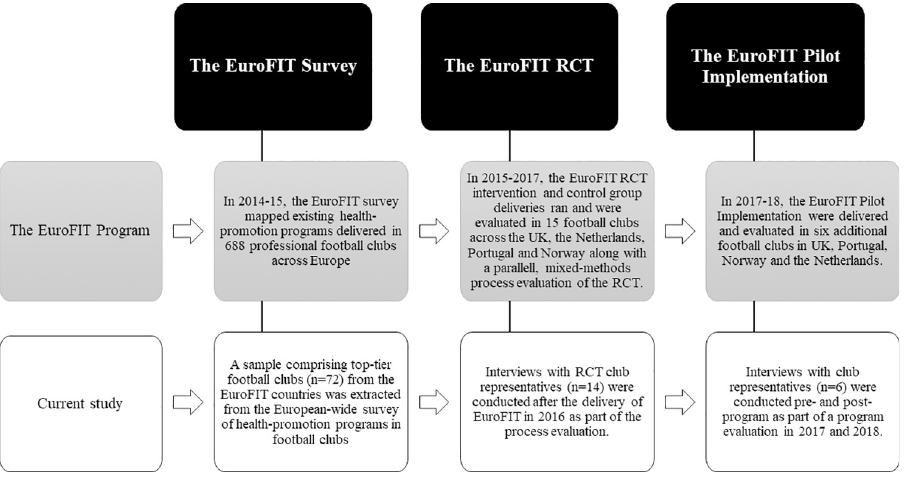
Fig 1. Timeline and overall process of the EuroFIT program and the data used for this current study.